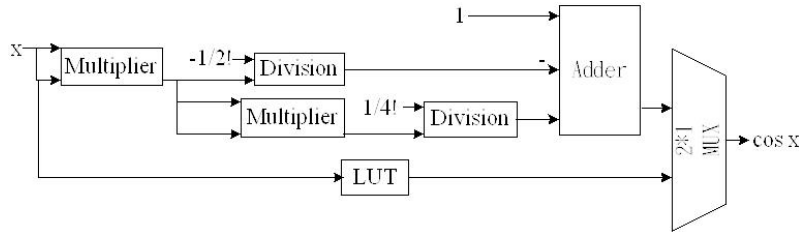
Figure 15. Block diagram of the sine function with the Taylor expansion and LUT.